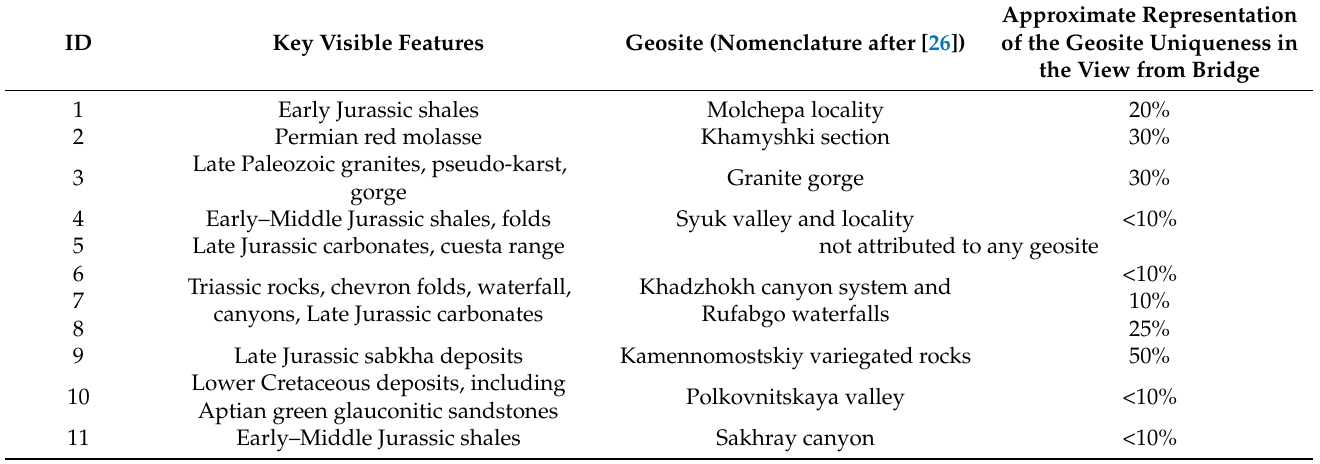
Table 3. Spatial relations of the bridge-based geoheritage viewpoints to the geosites of the Mountainous Adygeya geodiver- sity